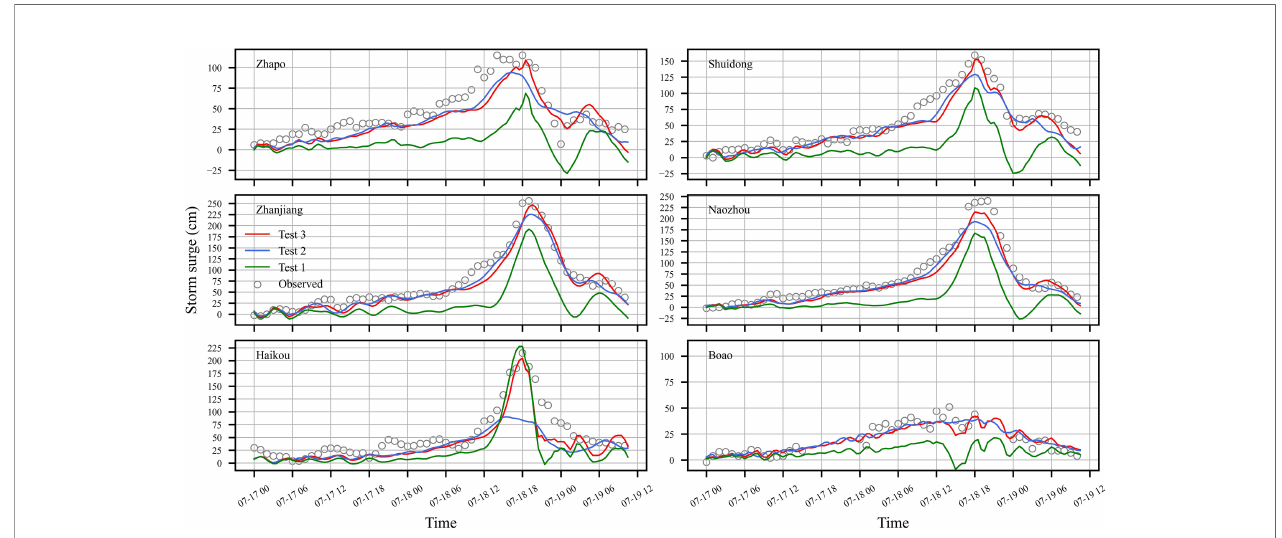
FIGURE 4 | Time series of observed (circles) and simulated storm surges (cm) during Test 1 (green line), Test 2 (blue line), and Test 3 (red line) at six tide gauge stations.